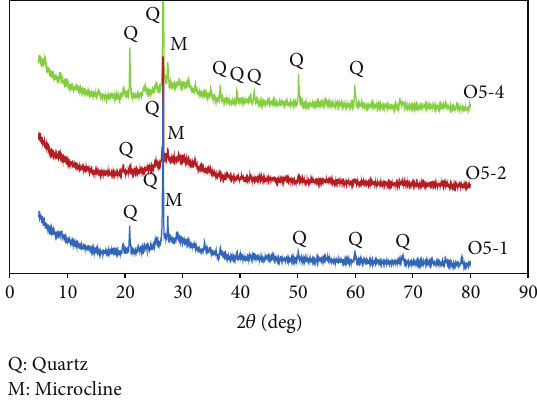
Figure 10: XRD patterns of geopolymers containing OPA, heat cured for 2 hours.